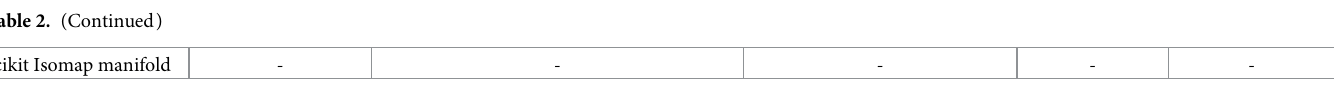
Table titles are as following: #cl(def)—number of clusters under default, "Executable"—number of probes (%) a tool able to use, "Sent Executable" -number of sentinels (selected meaningful periodic Tu et al.) probes a tool includes in analysis, "Sent Assigned Correct."—a number of sentinels assigned correctly into the same clusters, as co-reculated; Sent Cluster Collision—number of misallocation of co-regulated sentinels to different clusters. For example, CLICK assigning 9335 dataset makes one cluster. Clustering 61 Oxidative, 40 Reactive Building, and 45 Reactive Charging sentinels probes together. Given that there are 145 sentinels and 84 are sharing the same cluster, giving it a value of